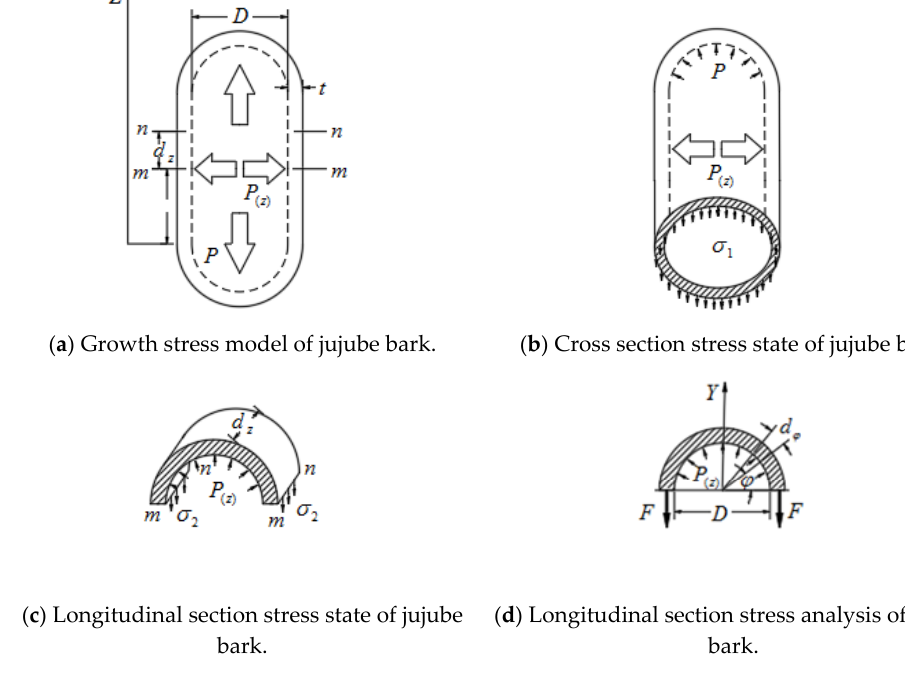
( a ) Growth stress model of jujube bark. ( b ) Cross section stress state of jujube bark.